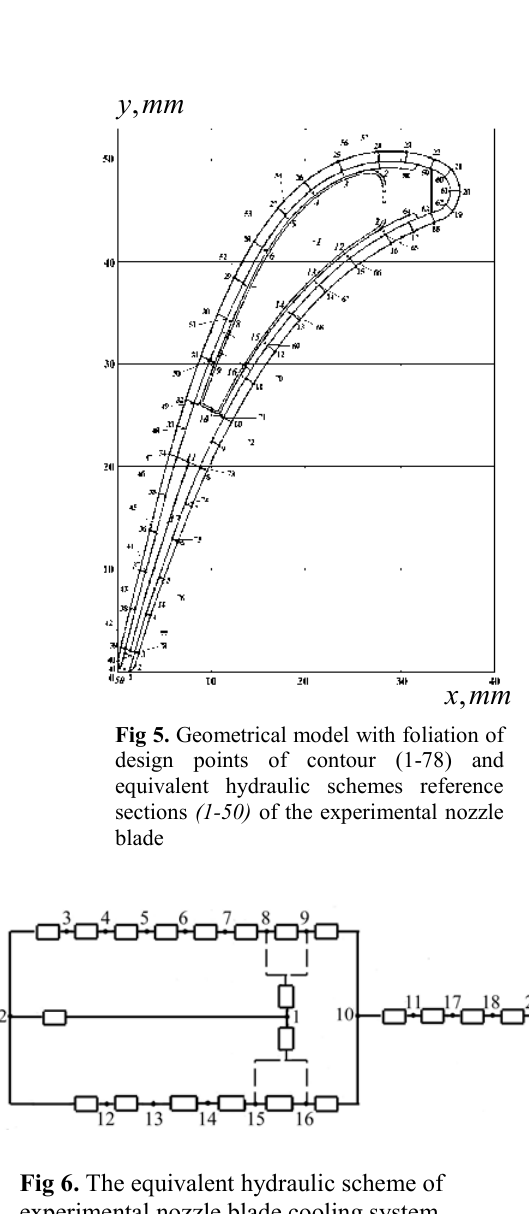
Fig 4. Distribution of the relative speeds l (1) and of gas convective heat exchange coefficients Г a (2) along the periphery of the profile contour